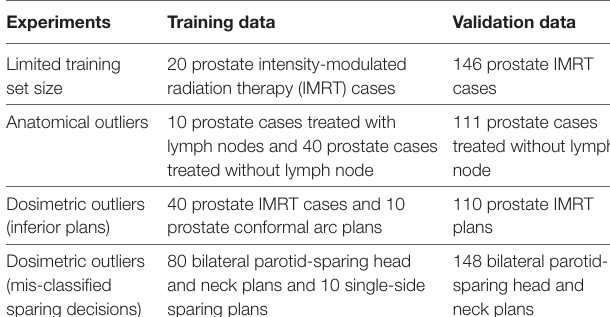
TaBle 1 | Summary of data used in the experiments.